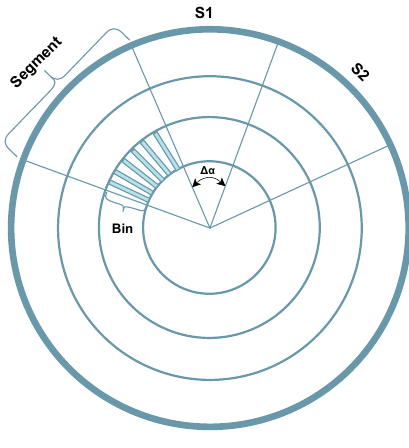
Figure 9. Visual representation of a Polar Grid